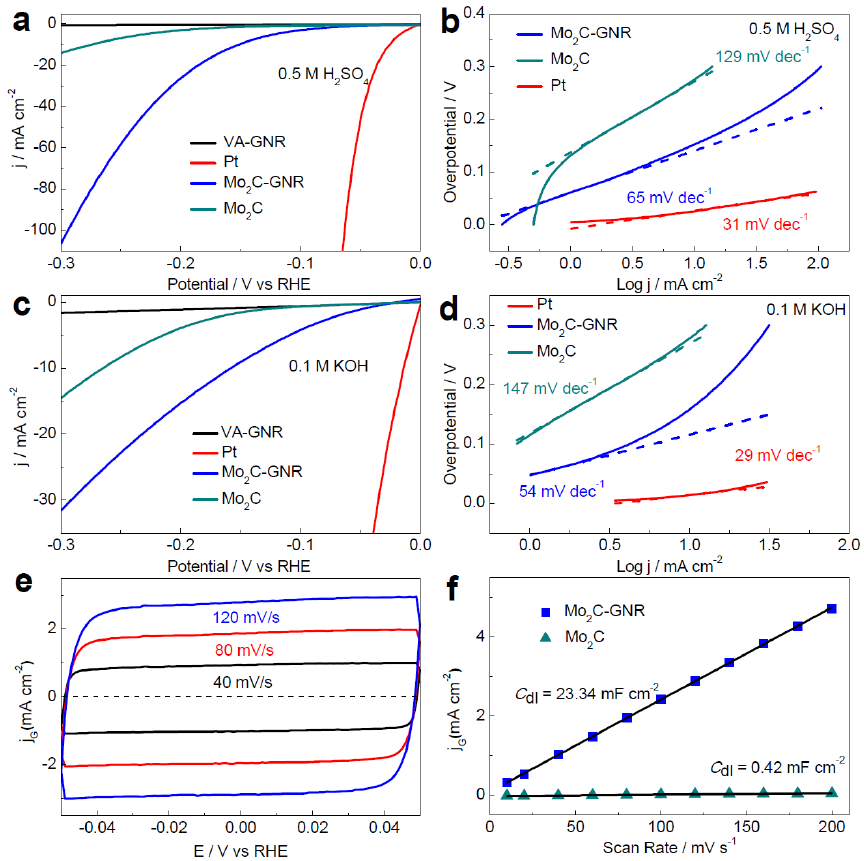
Figure 5. ( a , b ) LSV and Tafel slope plots of Mo 2 C nanocrystals over VA-GNR, bare VA-GNR